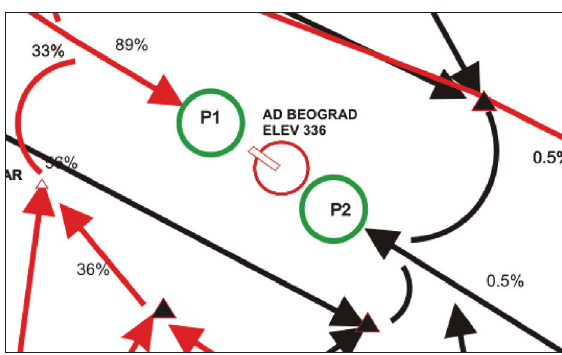
Fig. 10. The proposed location for pollution monitoring points